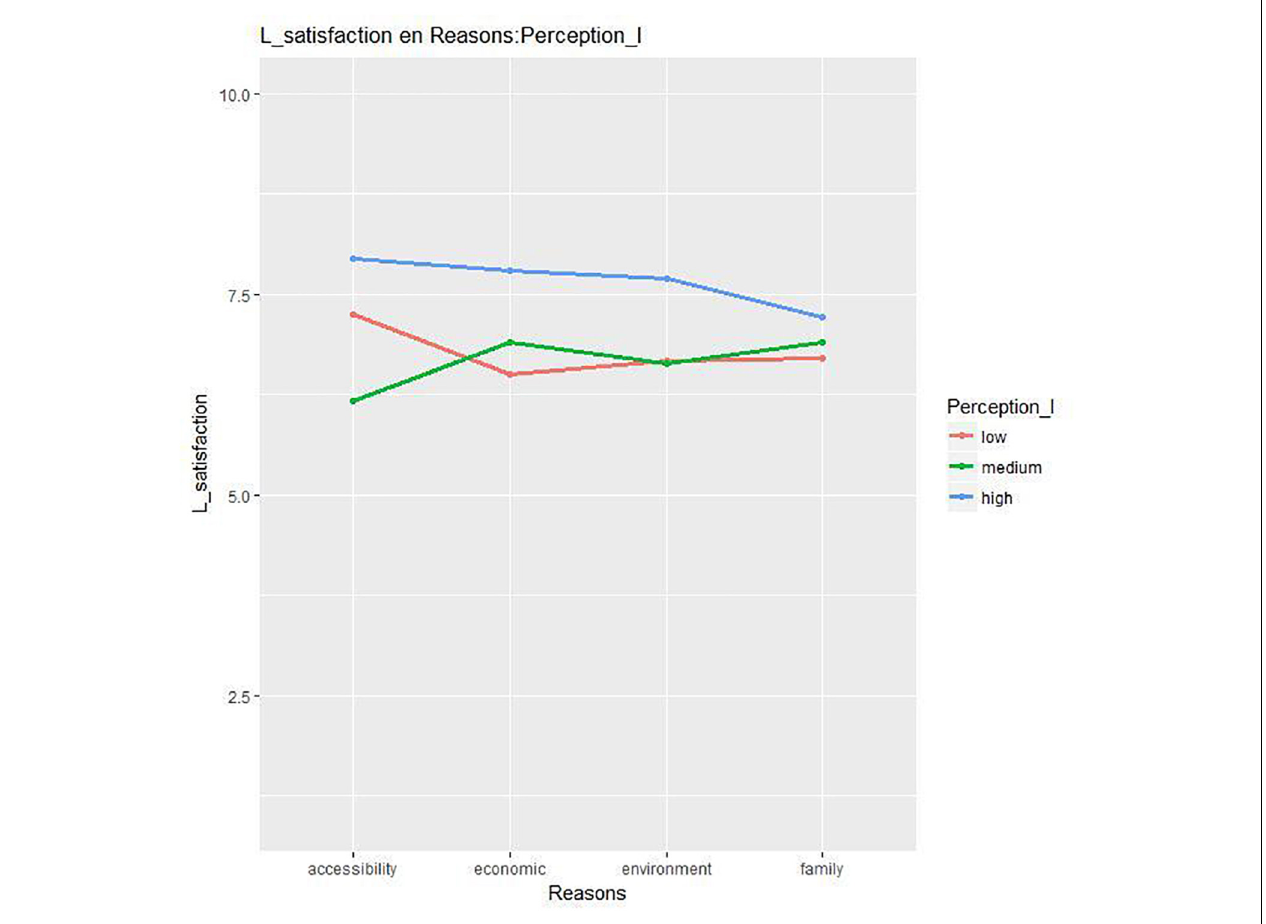
FIGURE 5 | Differences in life satisfaction by Level of perception ∗ Reasons